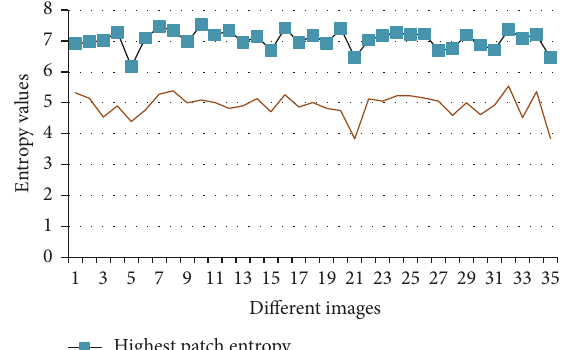
Figure 8: Comparison of the entropy value of candidate patch versus the entropy mean of all patches in each of the 35 tested images from source